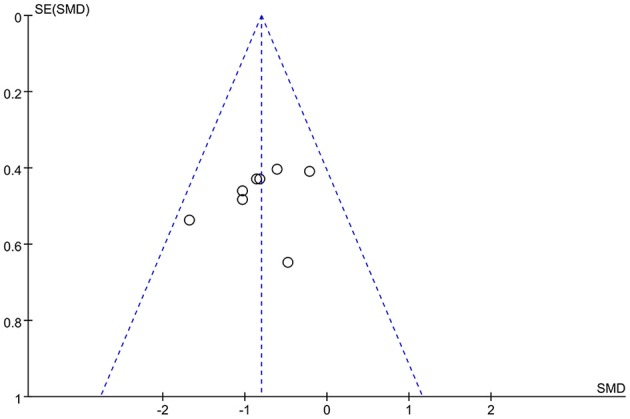
The risk of bias assessment of each study.